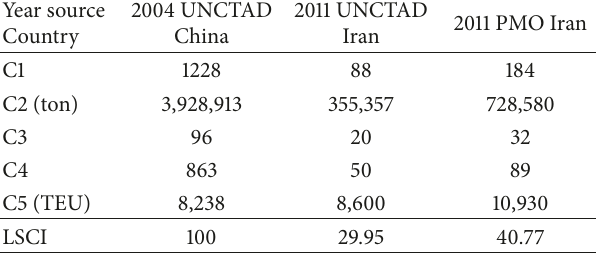
Table 7: Iran’s LSCI in terms of its components for 2011 based on UNCTAD and PMO data (the components of China in 2004 is presented as a source of calculation for Iran’s LSCI).